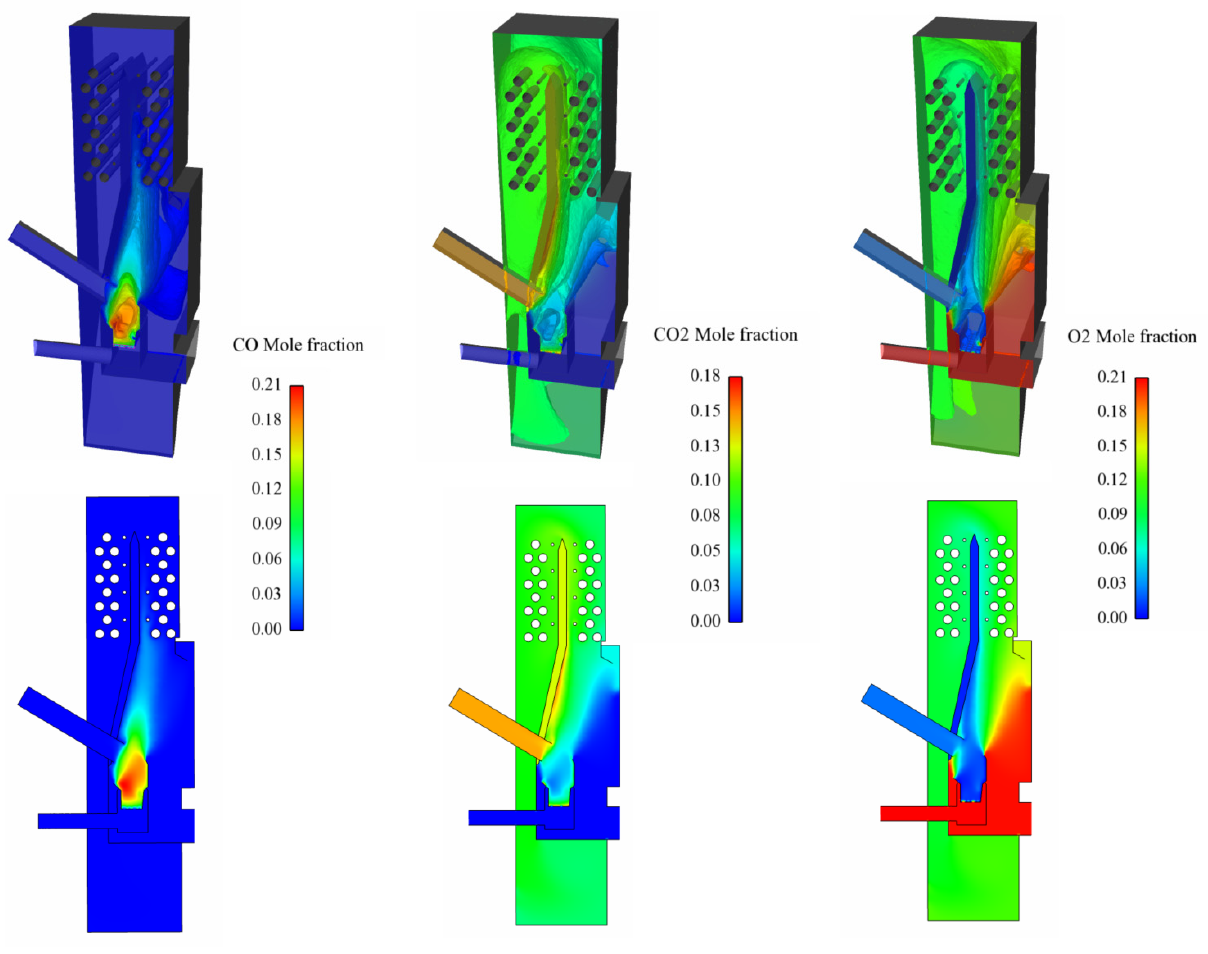
and O iso-sufaces and contours of the central axis section of the 2 2